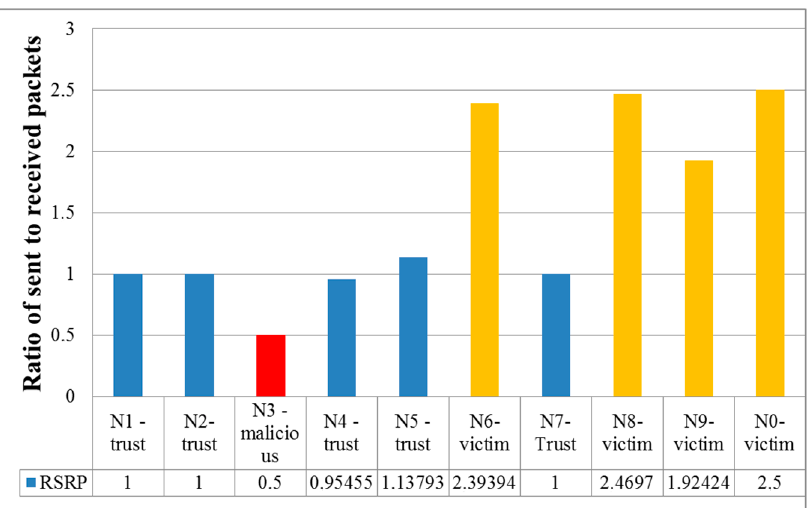
Figure 6. Ratio of sent to received packets Ratio s,r for trust, victim, and malicious nodes during DoS attack .